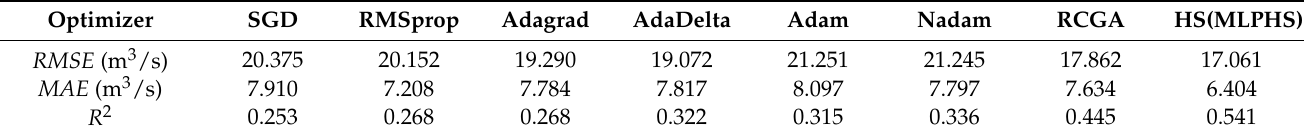
Table 2. Results obtained with each MLP.